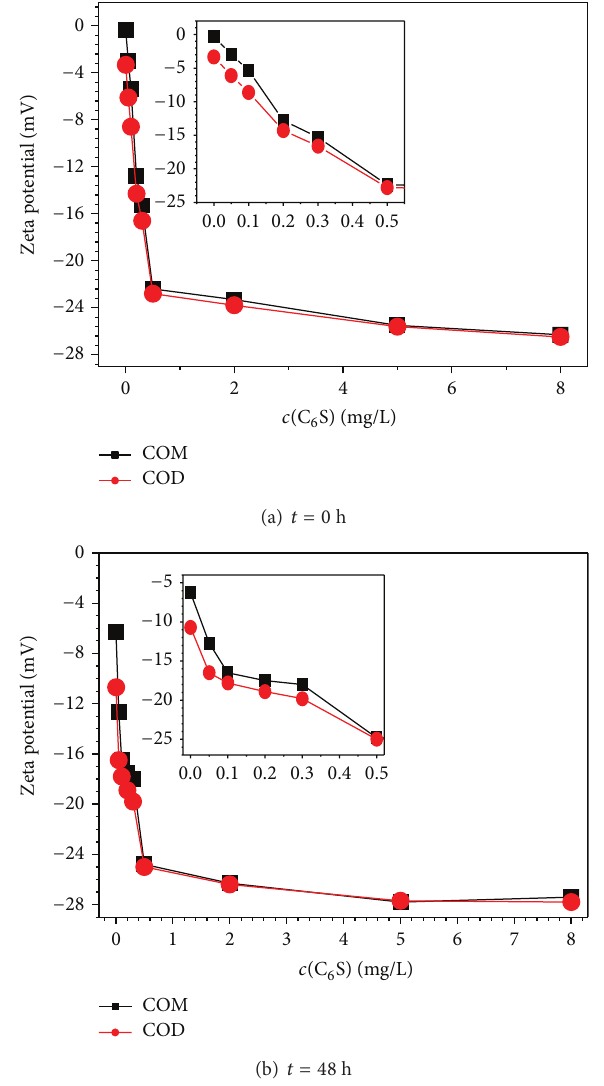
Figure 5: Effect of C 6 S concentration and acting time on Zeta potential of submicron COM and COD crystallites. (a) 𝑡 = 0 ; (b) 𝑡 = 48 h. The insets show the amplification figures when 𝑐 (C 0.5